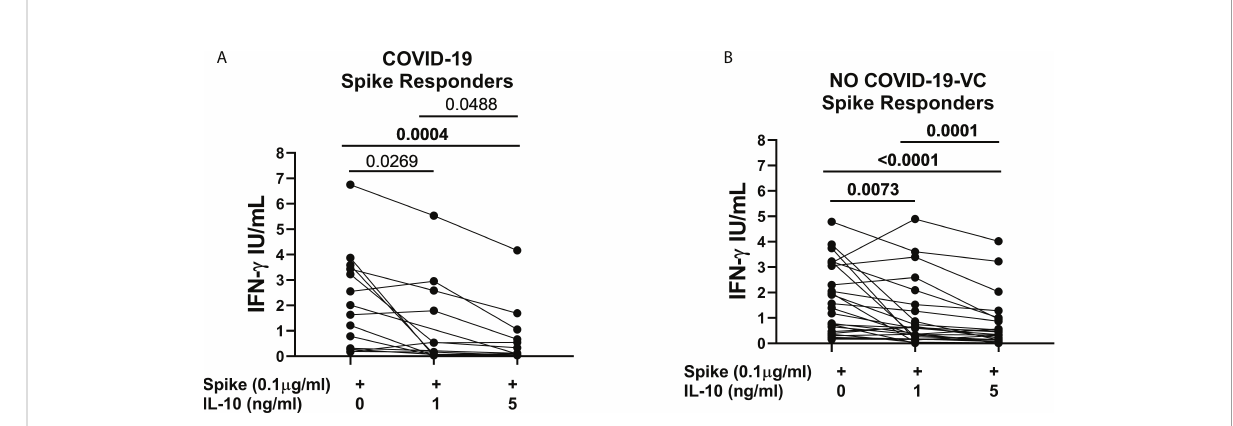
FIGURE 3 IL-10 signi fi cantly downregulates Spike-induced IFN- g response in COVI-19 patients and NO COVID-19-Vaccinated Controls (NO COVID-19- VC) of study population “ B ” . (A) COVID-19 patients, responders to Spike stimulation (n=14), (B) NO COVID-19-VCs, responders to Spike stimulation (n=25). IFN- g production in response to Spike (Pool S) was considered positive based on a cut-off (0.13 IU/mL) de fi ned in our previous study. After correction for multiple comparisons, p ≤ 0.016 was considered as signi fi cant.